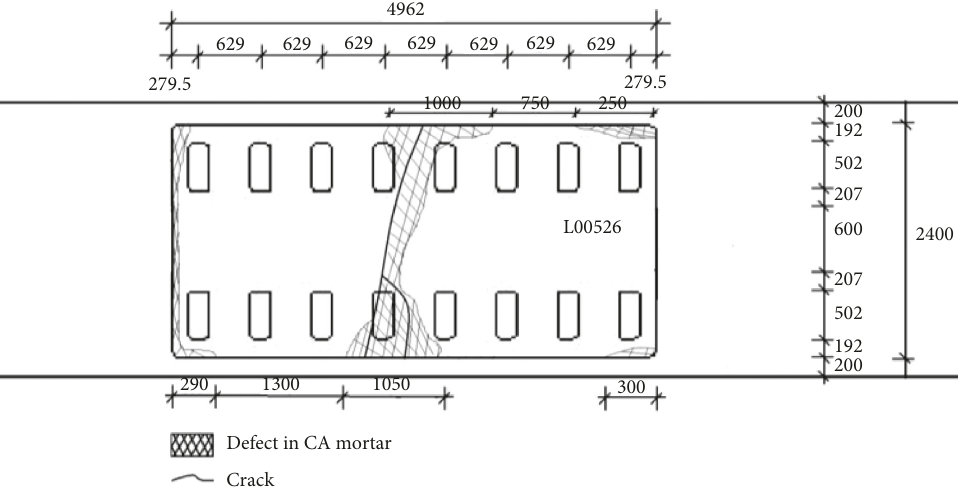
Figure 9: Defect distribution of L00526 track plate.